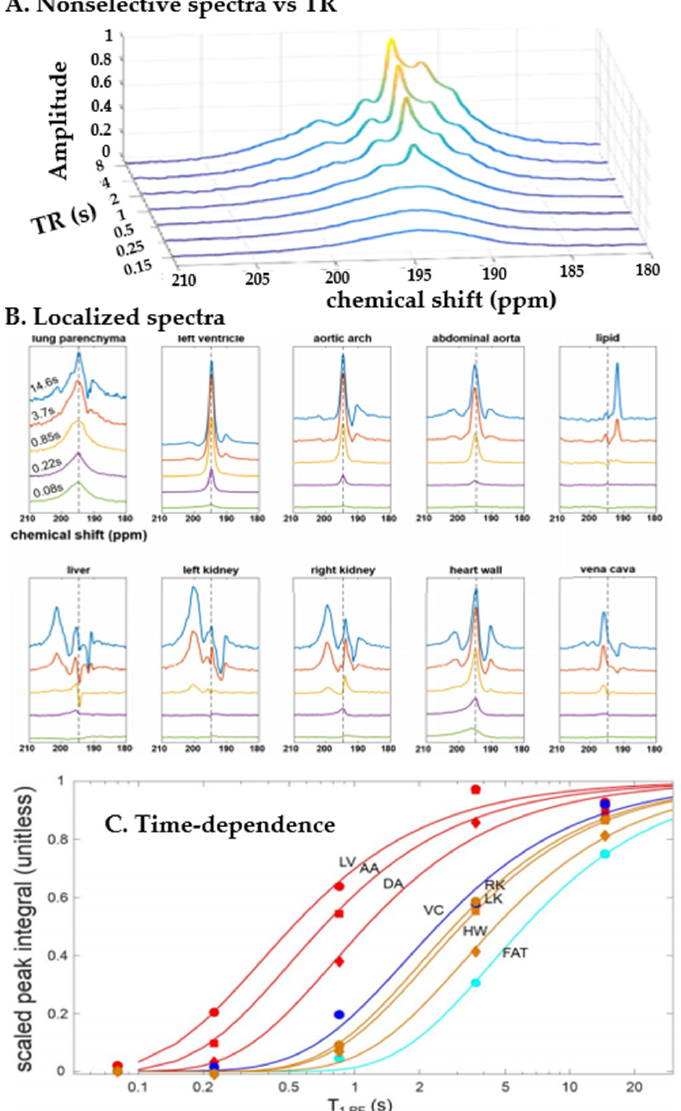
Figure 19. ( A ) Nonselective spectra acquired in a mouse as inhaled HXe is distributes throughout the body for progressively longer times. An initially broad, featureless peak is joined by five other